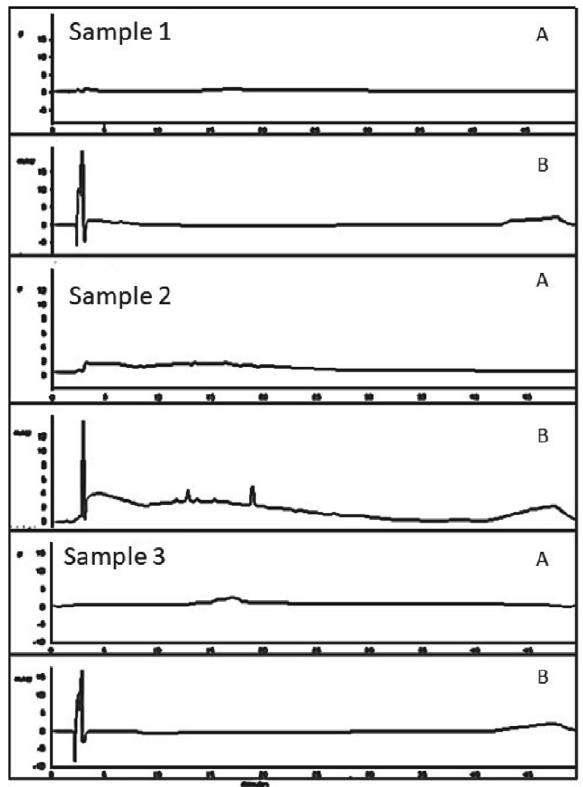
Figure 4 . Chromatograms of river water samples 1, 2 and 3. Chro- matograms A correspond to fluorescence detection λ ex 278 nm and λ em 450 nm. Chromatograms B correspond to UV detection at 280 nm. Conditions of analysis are described in the